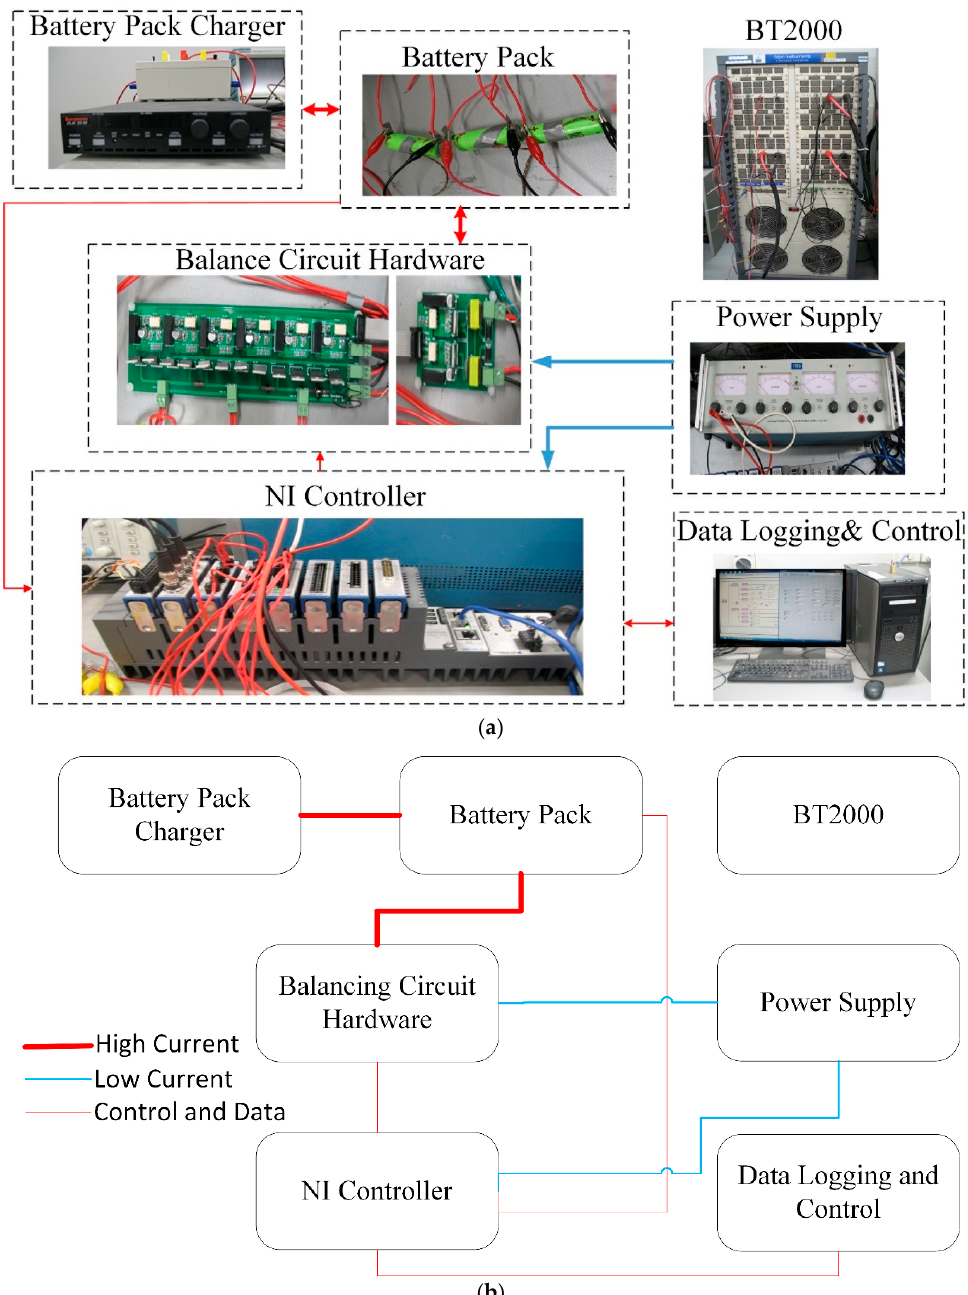
Figure 6. Configuration of the test platform for different balancing criteria implementation. ( a ) The hardware diagram and the connection; ( b ) the schematic diagram for this platform and their relationship.